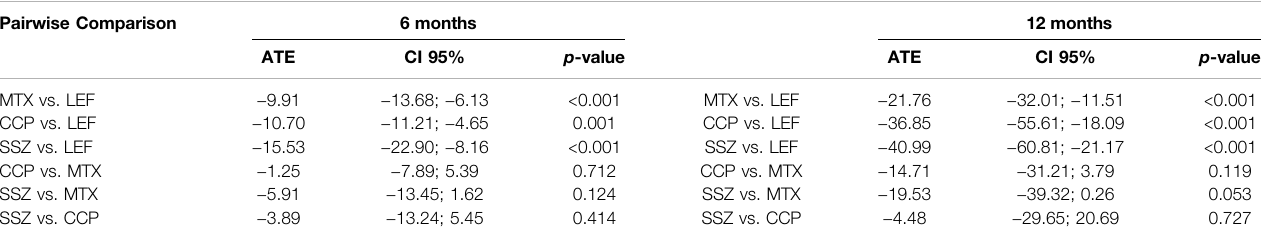
TABLE 3 | Average treatment effect after propensity score weighting: pairwise analyses. Pairwise